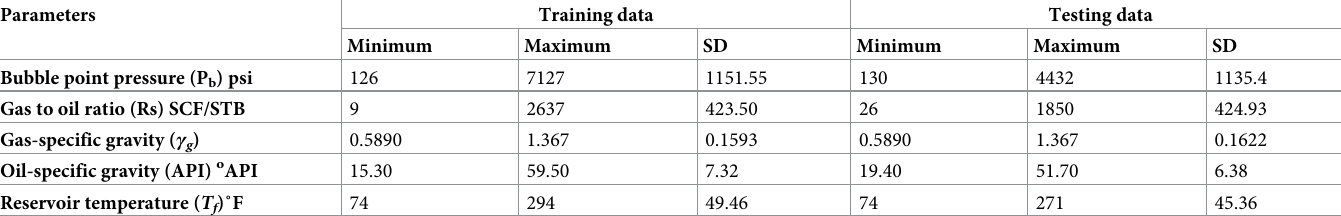
Table 2. Statistical description of the